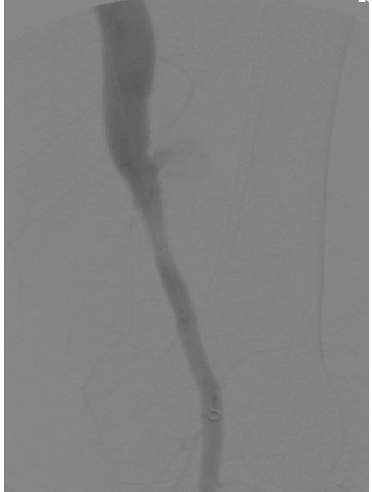
Figure 6: Superficial femoral arteriovenous fistula occluded after placement of iliac extender stent.